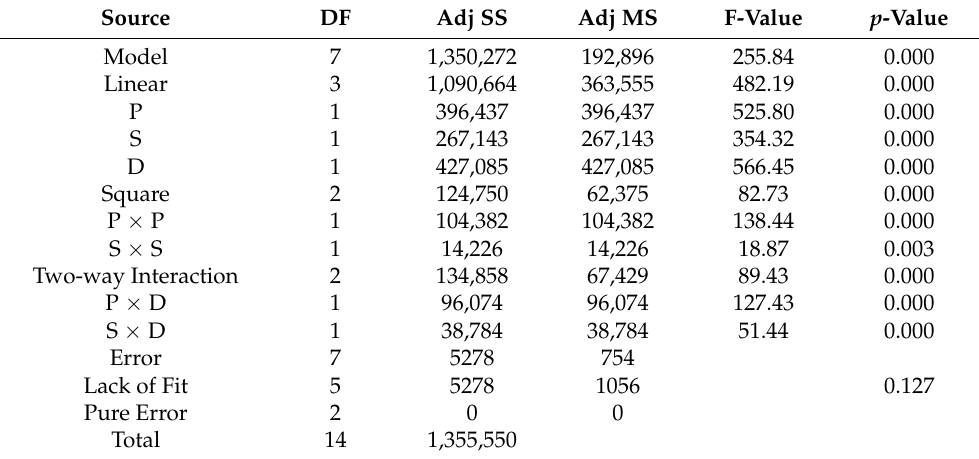
Table 3. The results of analysis of variance (ANOVA) for the radius of curvature of laser-formed cylindrical surfaces.